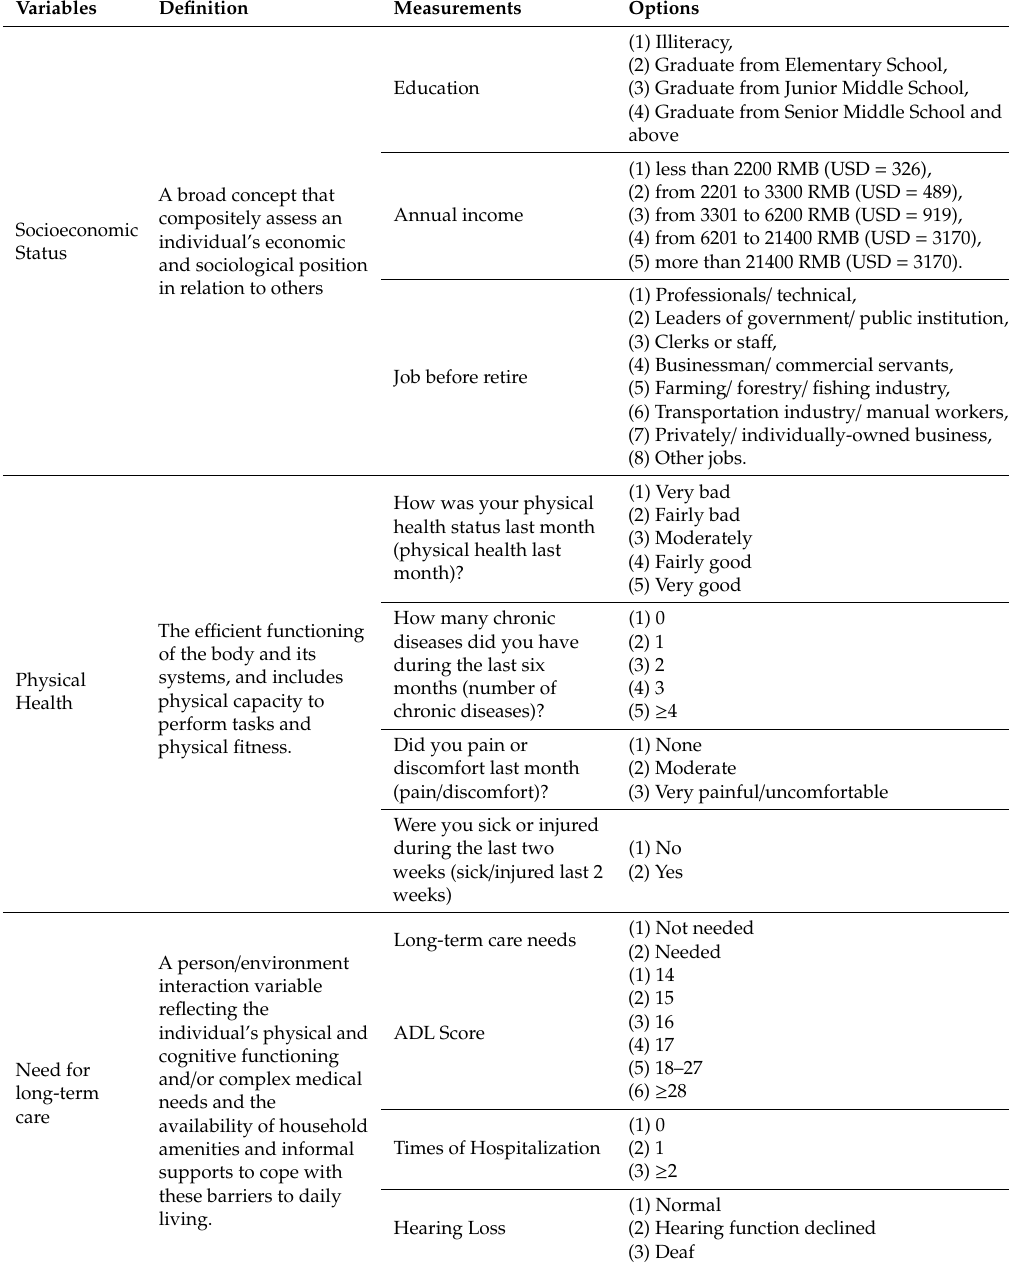
Table 1. Measurements of the variables in this